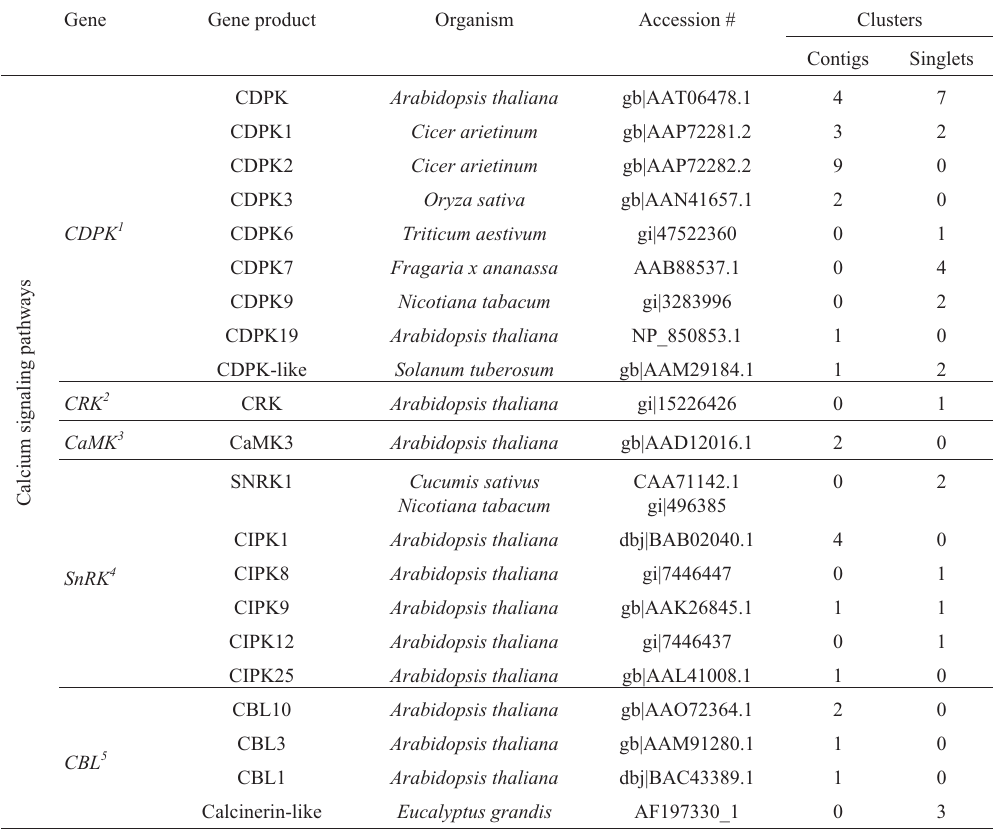
Table 1 - Ortholog genes of Calcium signaling pathways found in the Citrus EST